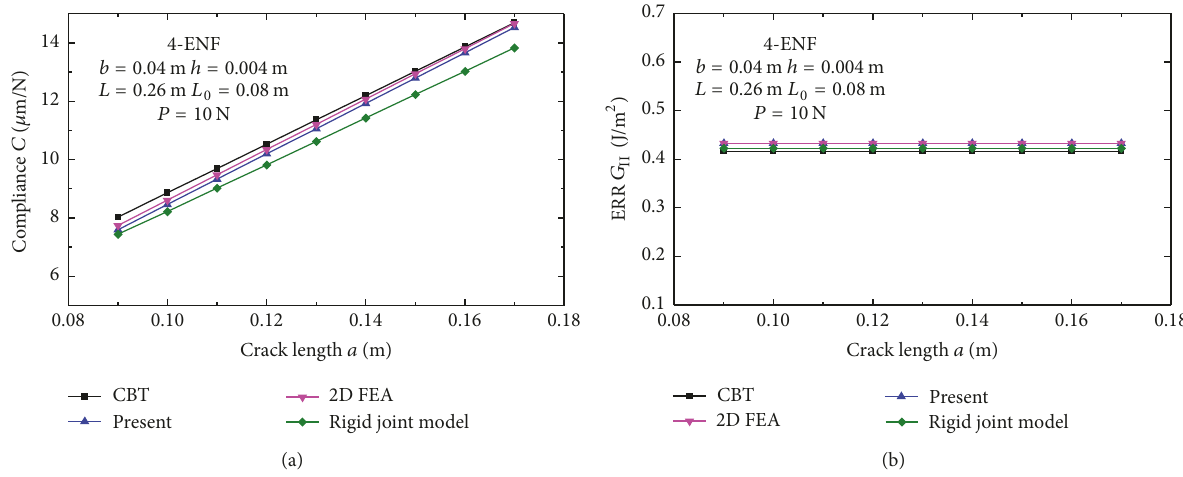
Figure 4: Typical compliance and ERR evaluated as a function of crack length for 4-ENF: (a) compliance; (b) ERR.